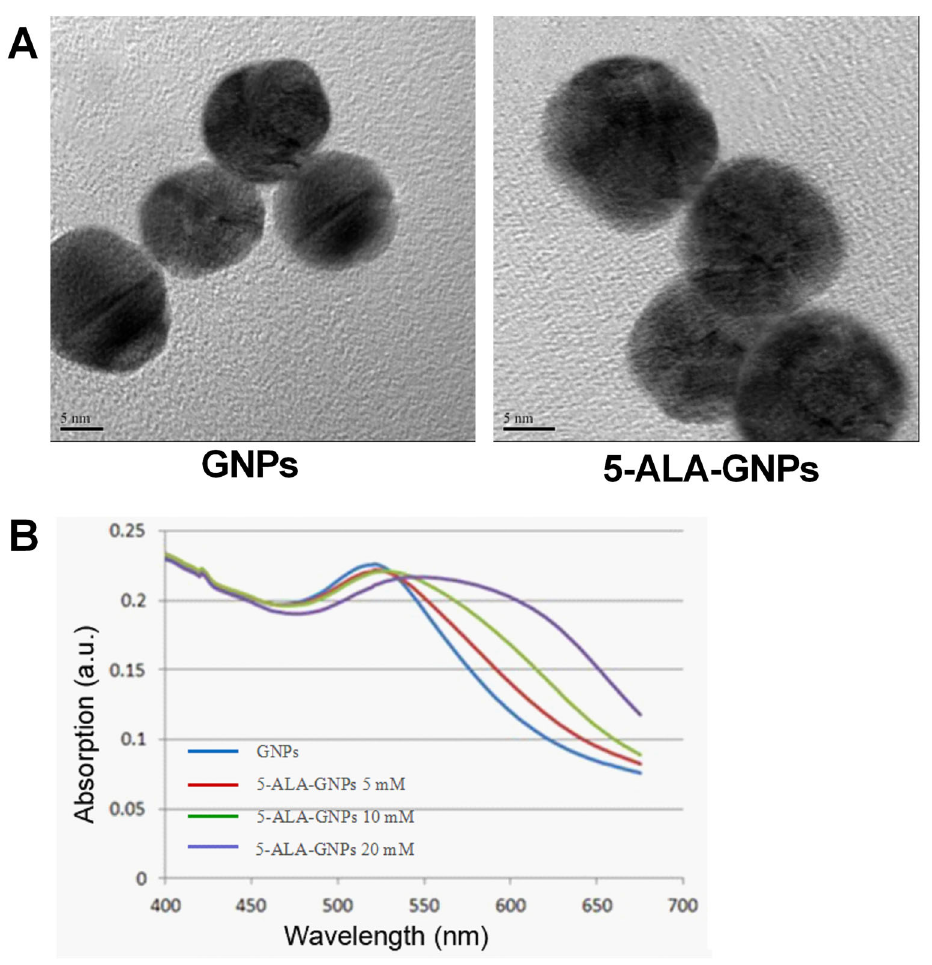
Figure 1. Transmission electron microscopy images and absorption spectra of gold nanoparticles (GNPs) and 5-aminolevulinic acid-(5- ALA)-GNPs. A , Transmission electron microscopy images of GNPs and 5-ALA-GNPs. Scale bars, 5 nm. B , Absorption spectra of GNPs and